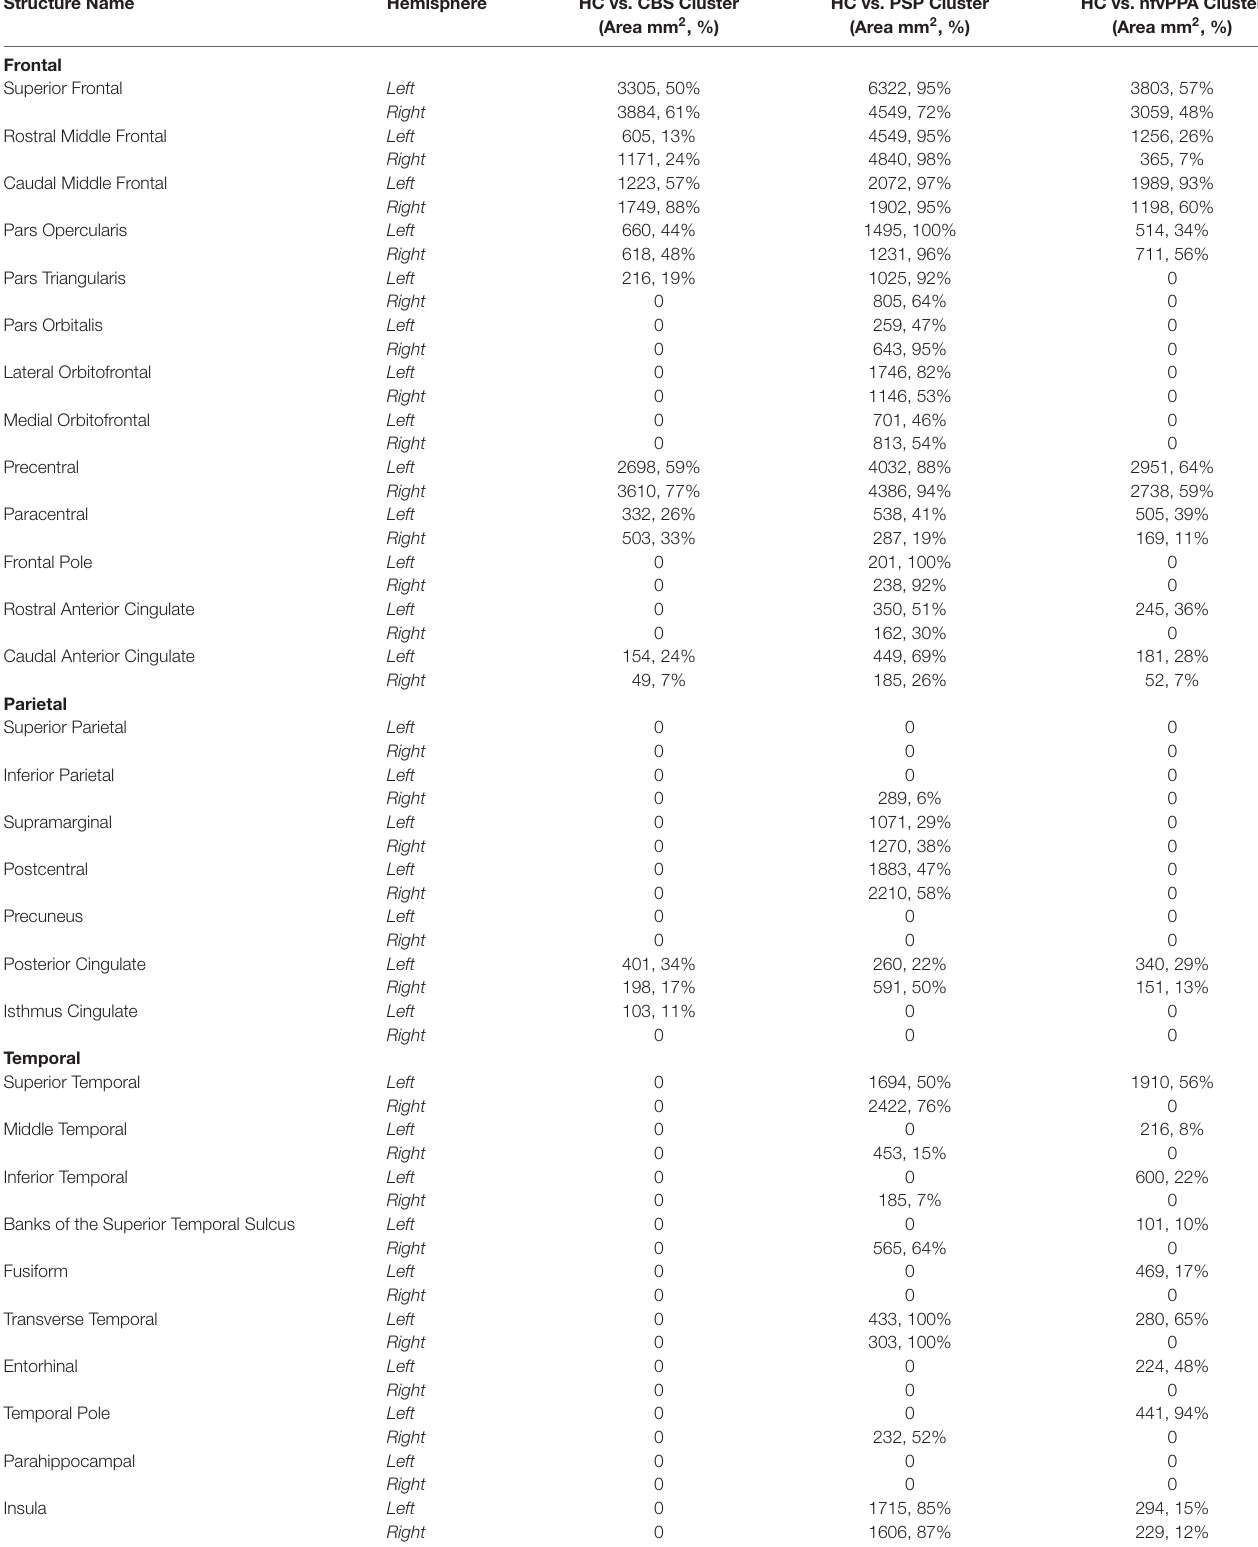
TABLE 2 | The overlap between each patient-control cortical thickness analysis cluster with Desikan-Killiany atlas regions shown in area mm 2 and percentage